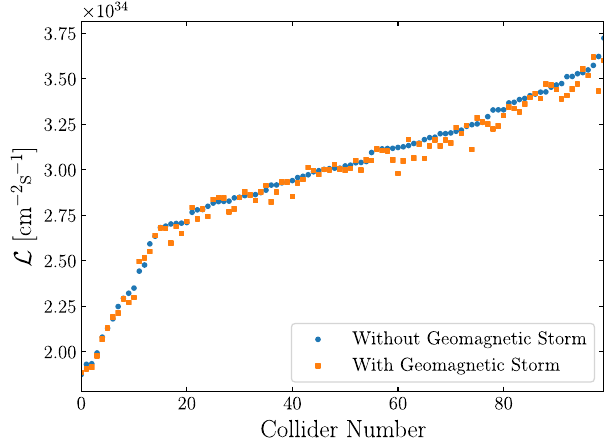
FIG. 16. Luminosity L vs collider number for 100 tuned colliders with static imperfections: with a geomagnetic storm (orange square) and without a geomagnetic storm (blue circle). Collider are ordered in ascending luminosity using the colliders without a geomagnetic